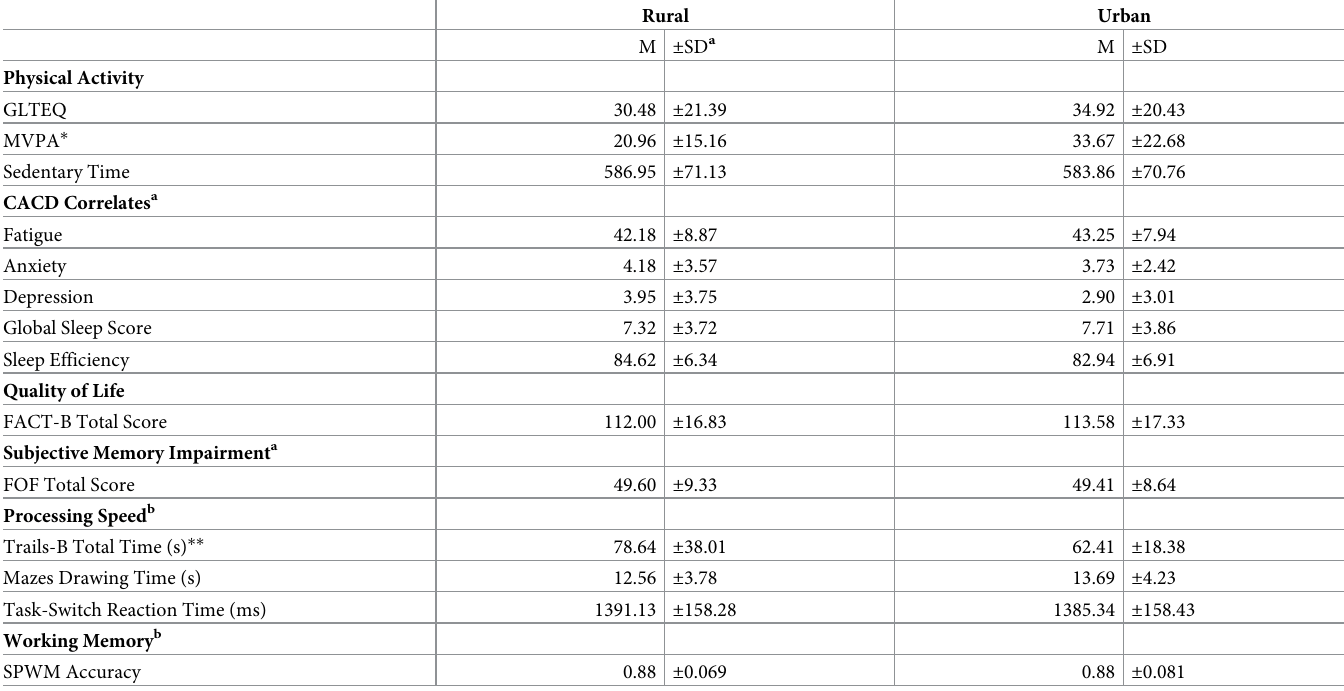
Table 2. MVPA, CACD correlates, and cognitive outcomes in rural and urban breast cancer